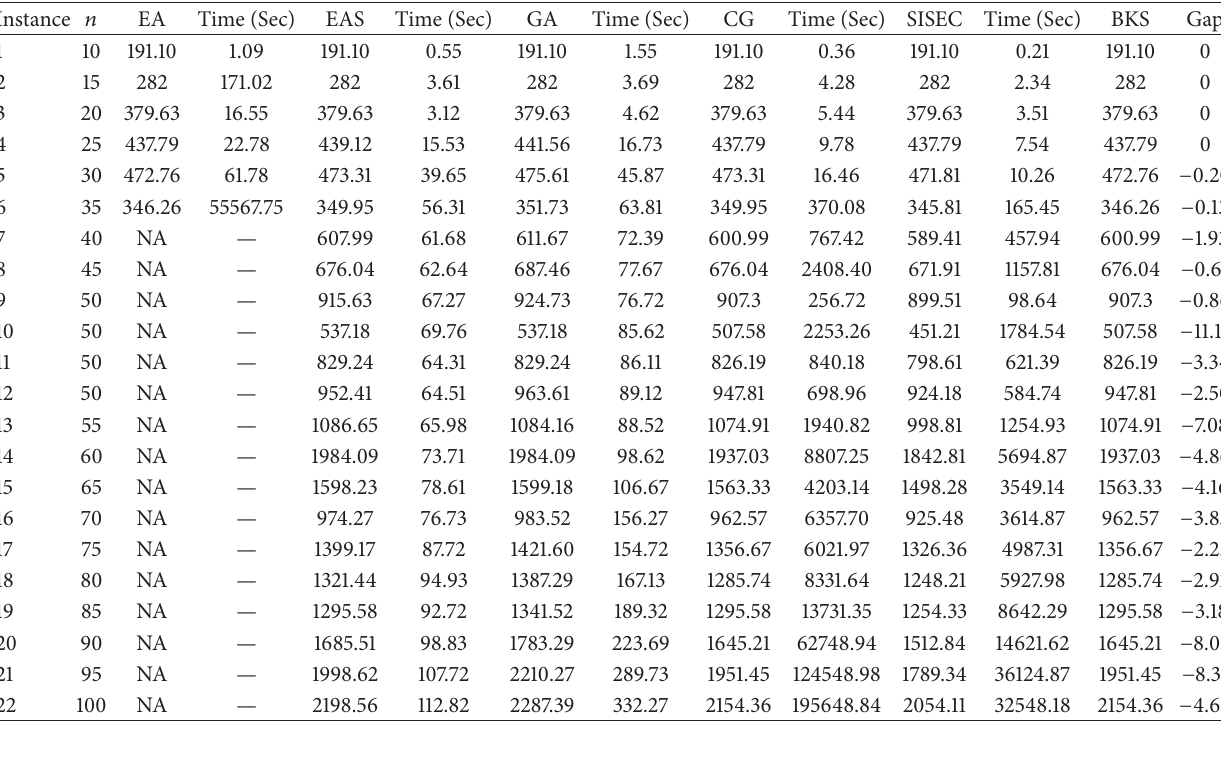
Table 2: Comparison results of the SISEC with some heuristic and metaheuristic algorithms.